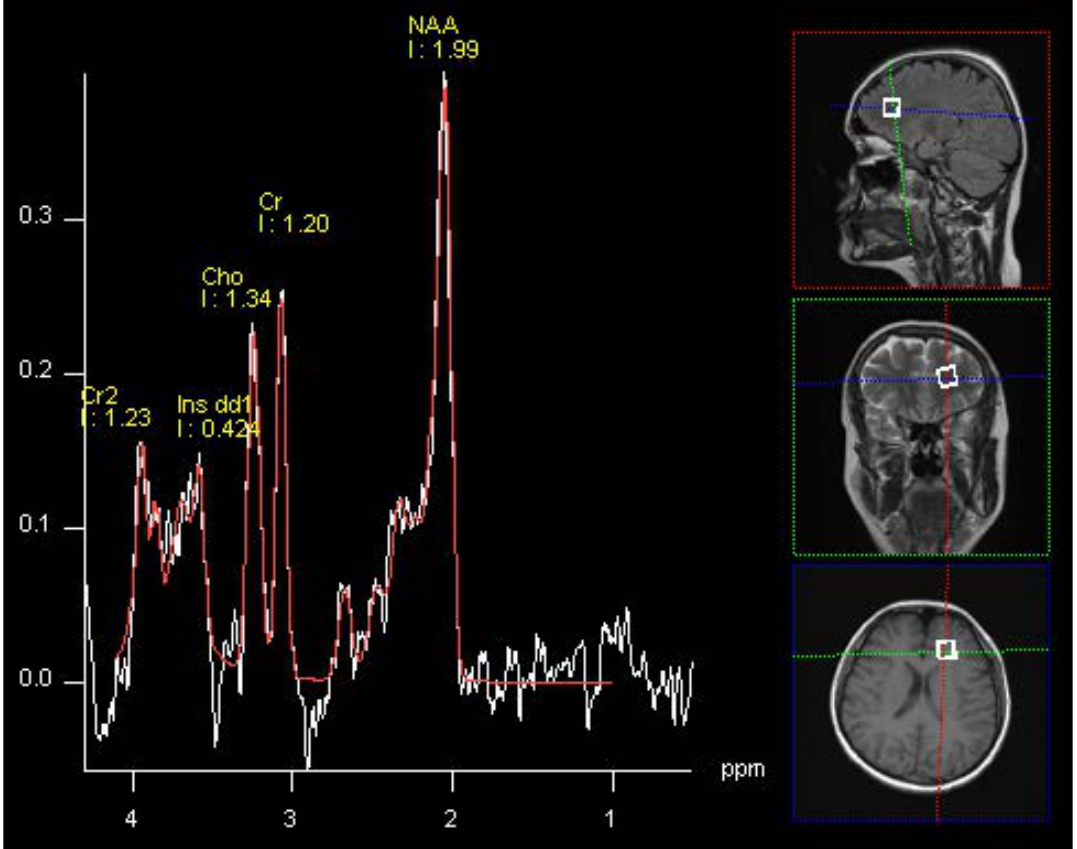
Figure 1. Images showing voxel location in the left WM area and an example of spectra before (white line) and after (red line) fitting. Peak areas for N -acetylaspartate (NAA); creatine (Cr and Cr2); choline (Cho); and myo -inositol (Ins dd1) are